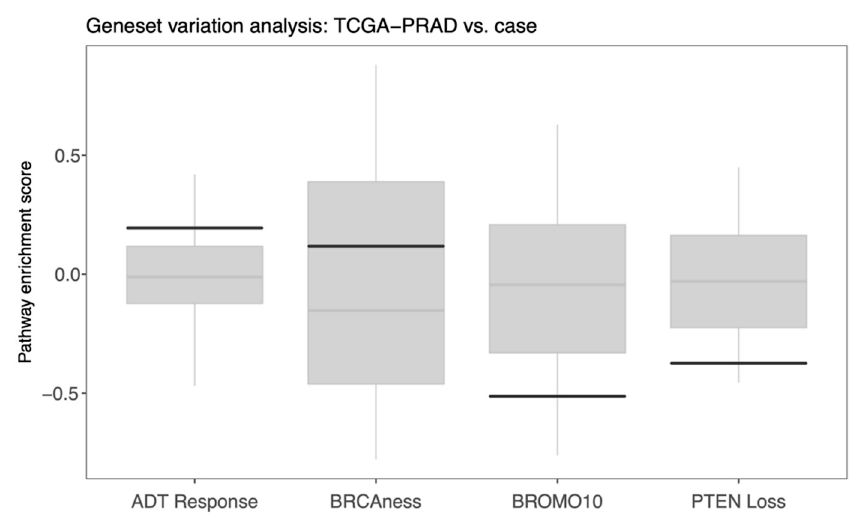
Figure 5. Gene set variation analysis of gene signatures attributed to ADT response, HR deficiency/BRCAness, response to bromodomain inhibitors (BROMO10) and aberrant PTEN tumor-suppressor pathway activity. Signature enrichment scores were calculated for all the prostate adenocarcinoma samples in TCGA (Gleason score >= 8, n = 201). In the boxplots, scores for our case are indicated with solid black lines, and median scores in TCGA-PRAD are indicated with gray horizontal lines.